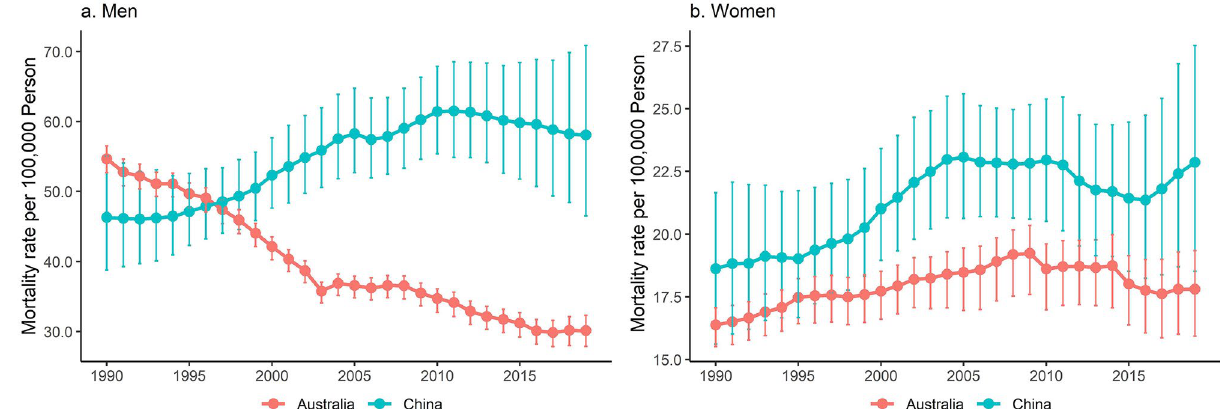
Figure 1. Age-standardized mortality rate of lung cancer by sex in China and Australia, 1990 to